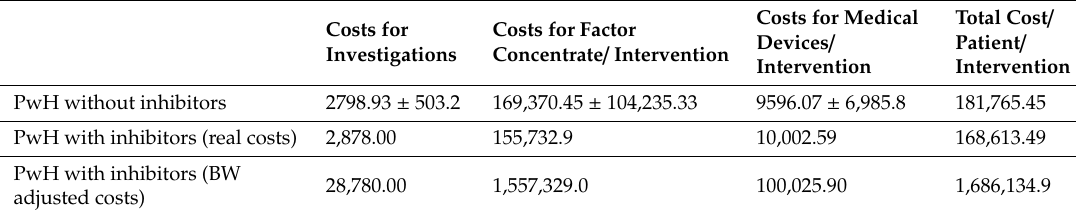
Table 9. Distribution of the real costs in invasive procedures patient / year (EUR) in invasive surgery and the impact on costs of inhibitors